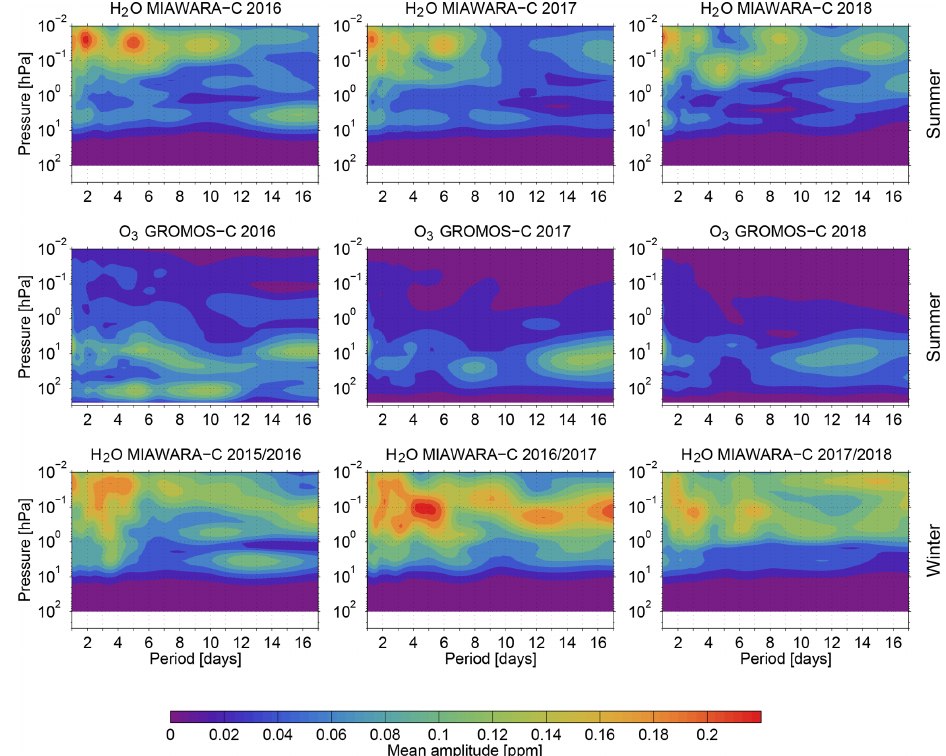
Figure 15. Mean amplitude for periods of 1–17d obtained by bandpass filtering the water vapour and ozone time series for 80d intervals centred around summer and winter solstice of the years 2015–2018.